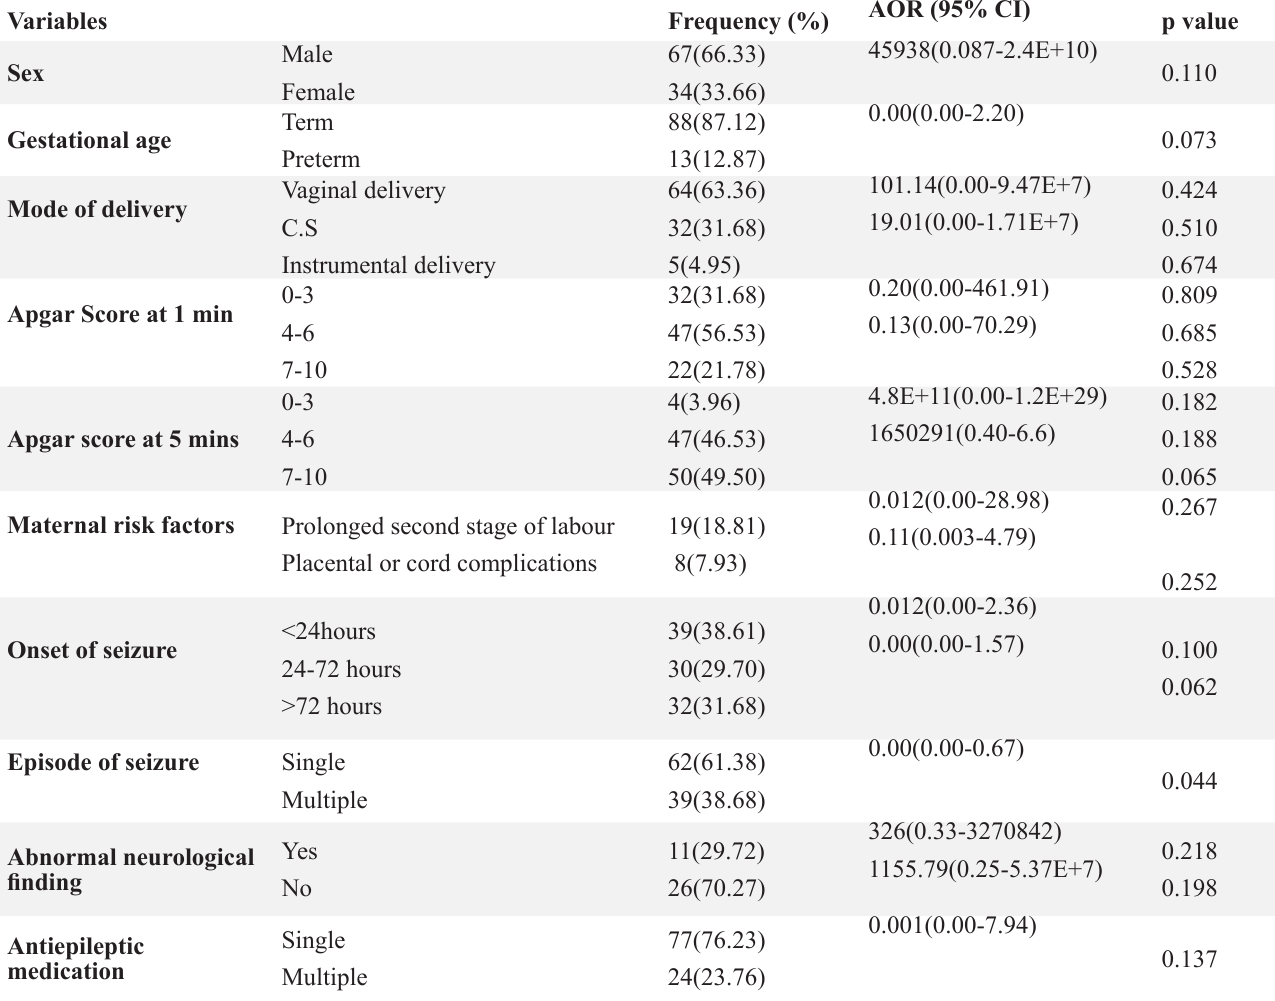
Table 2. Risk factors for developmental delay (N=117) Variables